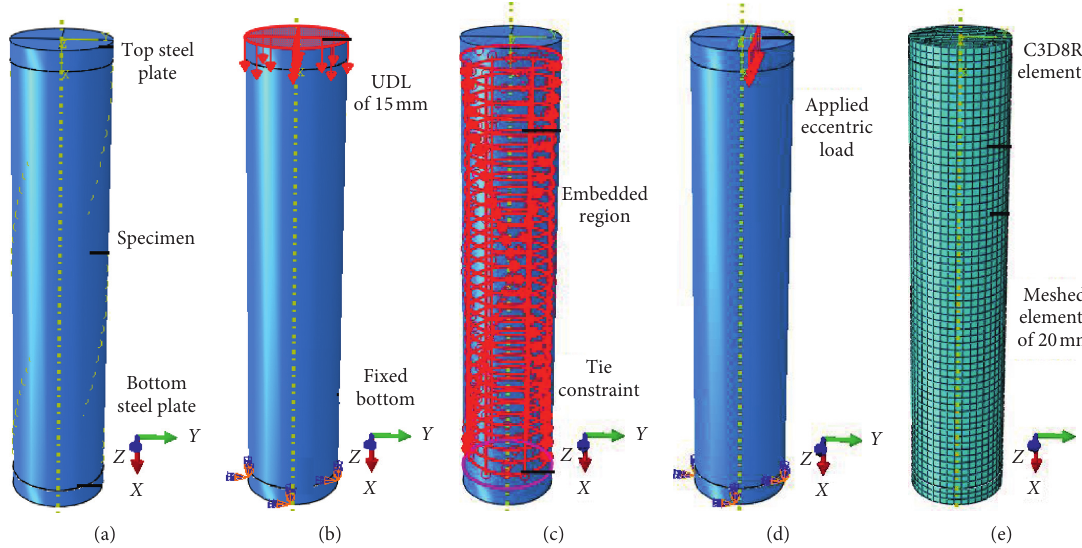
Figure 3: Simulated FEM: (a) geometry of HFRC column; (b) boundary conditions for concentric columns; (c) interaction between reinforcement and HFRC; (d) boundary conditions for an eccentric column; (e) constraints between load plates and